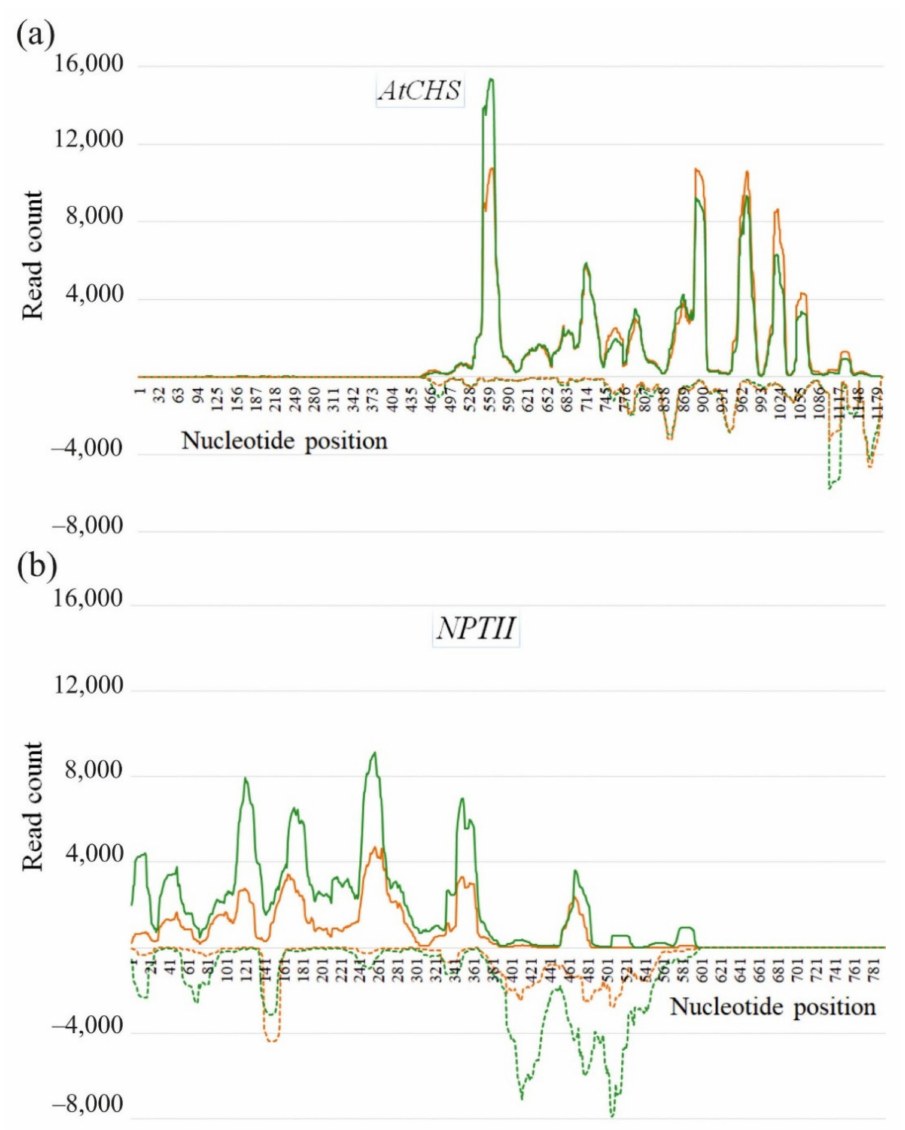
Figure 5. Strand-specific distribution of the 17–30-nt AtCHS- and NPTII- encoding sRNAs detected in Arabidopsis thaliana after dsRNA treatments along the AtCHS ( a ) and NPTII ( b ) gene coding regions. Read depth was counted by the number of reads on each position. Sense strand is plotted with a solid line above the x-axis, and antisense strand is plotted with a dotted line below the x-axis. Green and orange colors indicate two biological